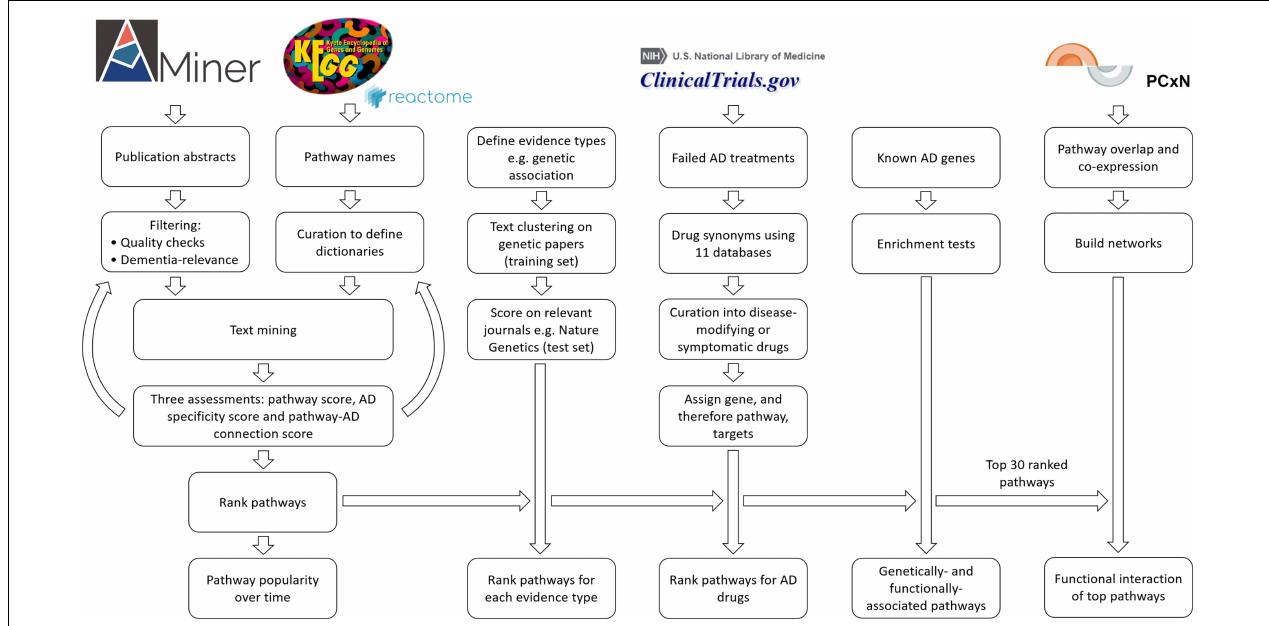
FIGURE 1 | Flowchart outlining the study methods. For the filtering of publications, we kept only studies with an abstract and with the terms Alzheimer or dementia . We removed duplicates, abstracts with negative findings, abstracts with dementia as an exclusion criterion, abstracts that were too long or too short, and finally, all keywords if there were more than 30 ( Supplementary Methods